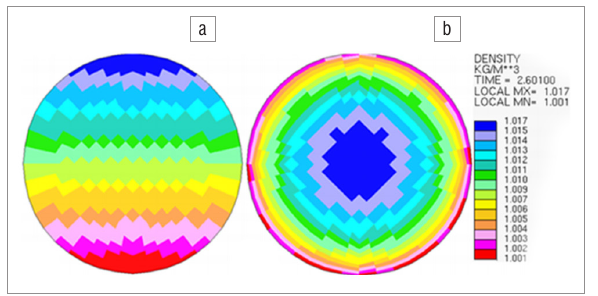
Figure 1: Cross-sectional density profiles of a spinning pipe gas lens showing (a) the initial state after heating and (b) the rotating steady-state near the end face of the pipe, with high density centre (blue) and low density edges (red). a b